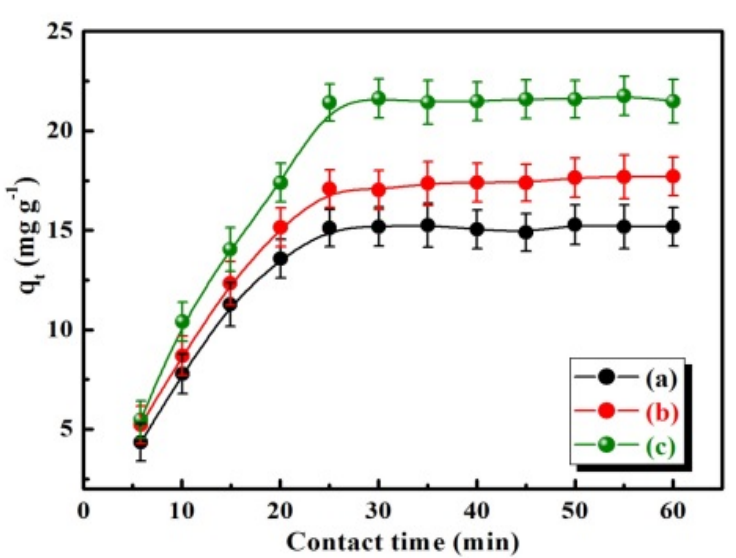
Figure 8. Time ‐ dependence of MB adsorption onto BiFeVOx.y for ( a ) y = 0.03, ( b ) y = 0.07, and ( c ) y ( c ) y = 0.15, in the dark. = 0.15, in the dark.